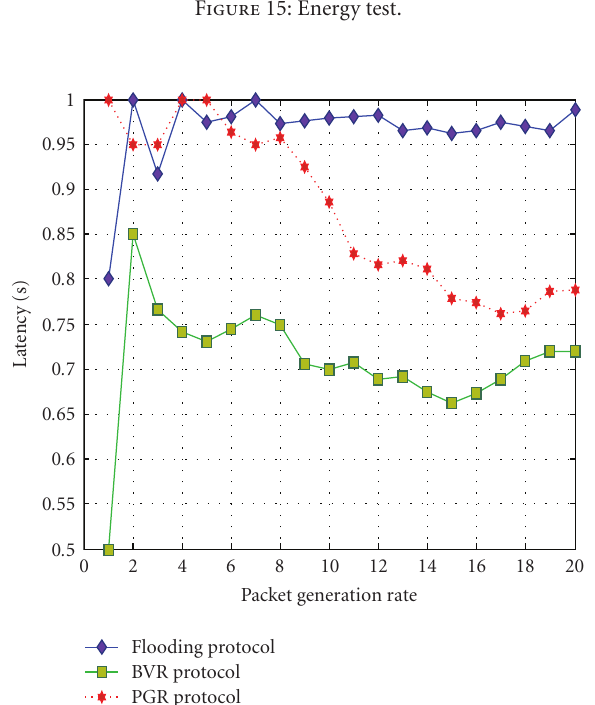
Figure 17: Average packet delay test.